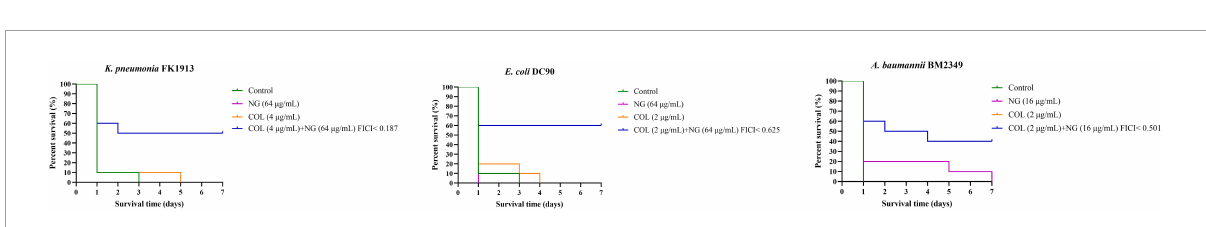
FIGURE5 Survival rate of Galleria mellonella after 7 days of monotherapy or combination therapy against colistin-resistant Klebsiella pneumoniae FK1913, Escherichia coli DC90, and Acinetobacter baumannii BM2349. Naringenin (NG) and colistin